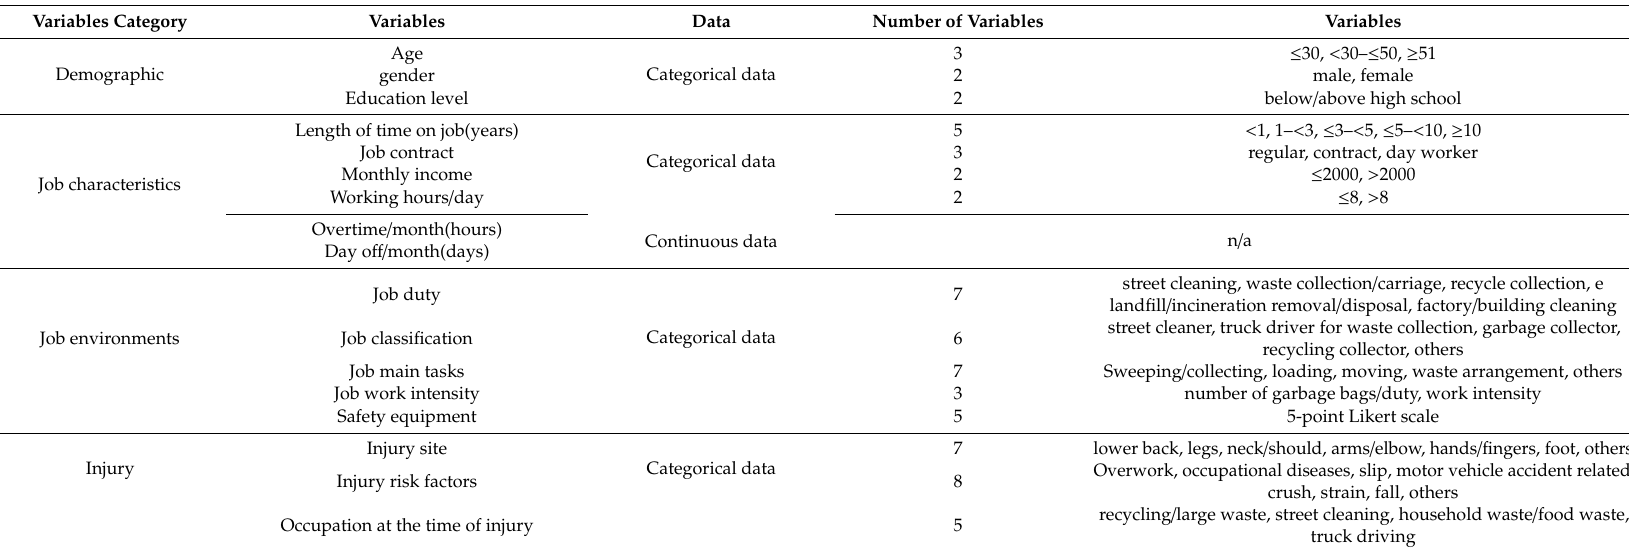
Table 1. Street cleaner characteristics and injuries